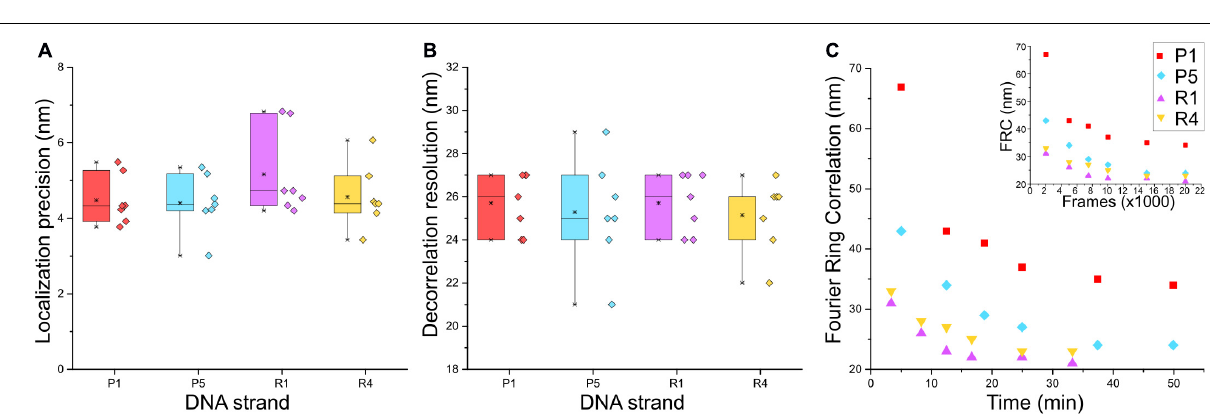
FIGURE 3 | Comparison between P1, P5, R1, and R4 DNA-PAINT strands for (A) localization precision by nearest neighbor analysis (Endesfelder et al., 2014) and (B) rendered image resolution by decorrelation analysis; n = 7. (C) Fourier Ring Correlation (FRC) resolution trend of the four strands over image acquisition time and FRC over number of frames (inset); n =